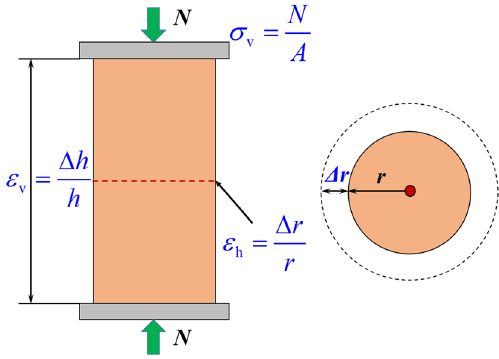
Figure 5. The axial and lateral strain of the specimen.